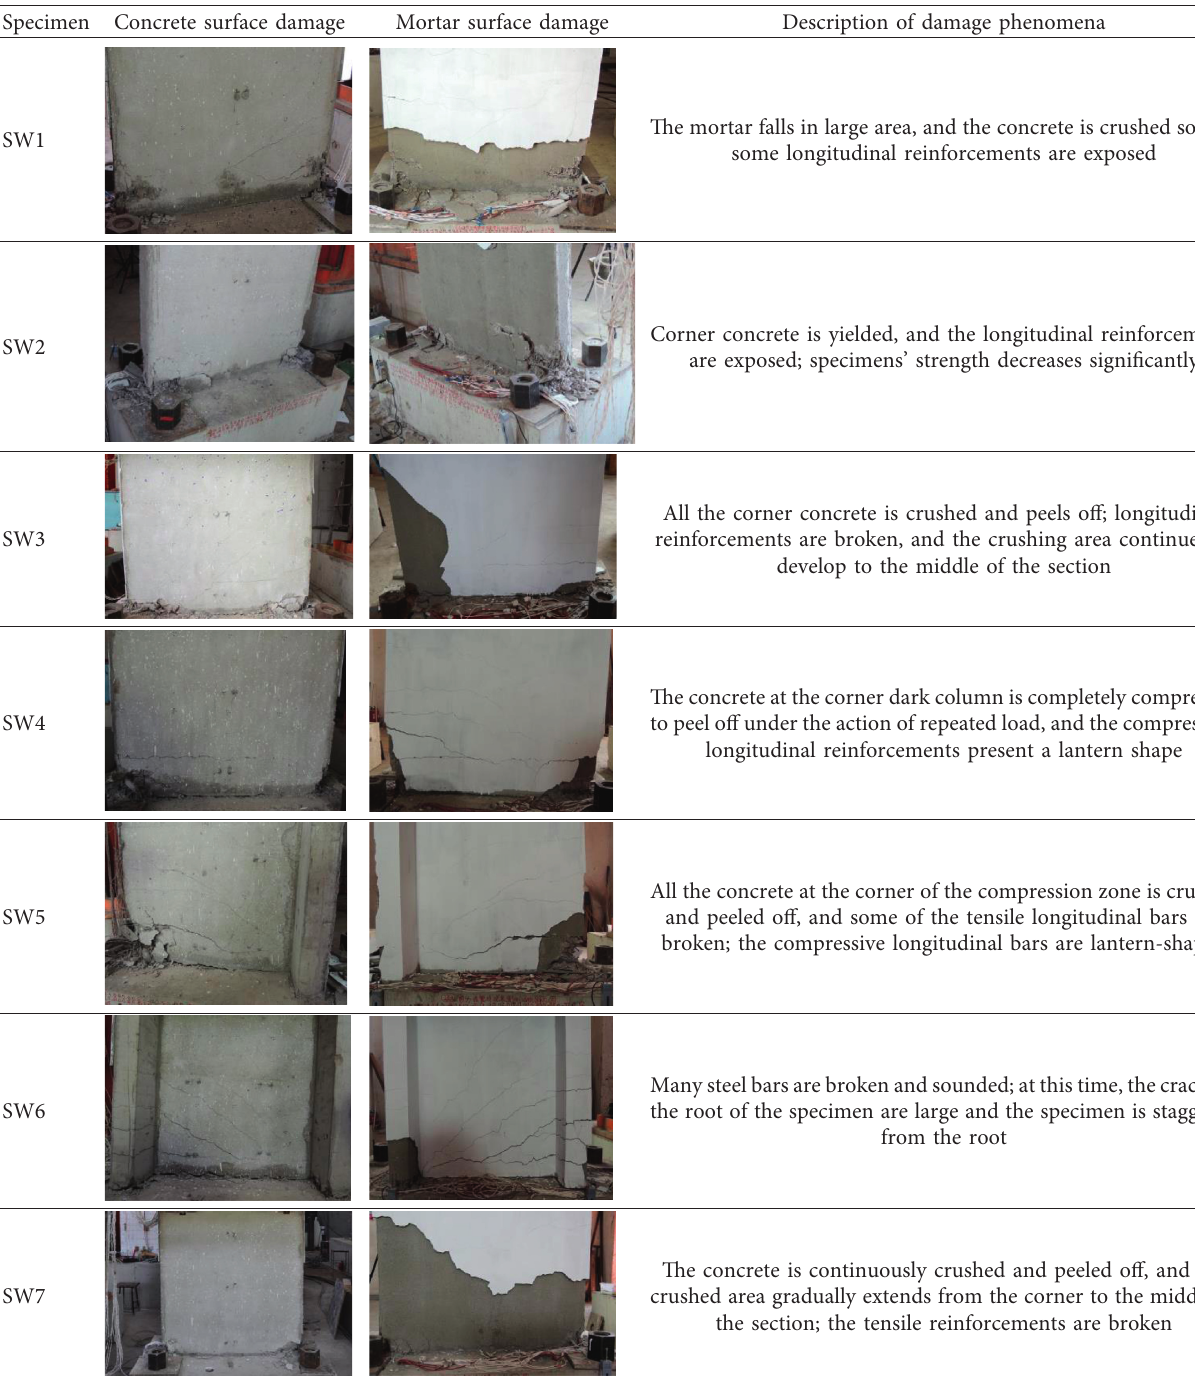
Table 3: Damage pictures of the seven shear